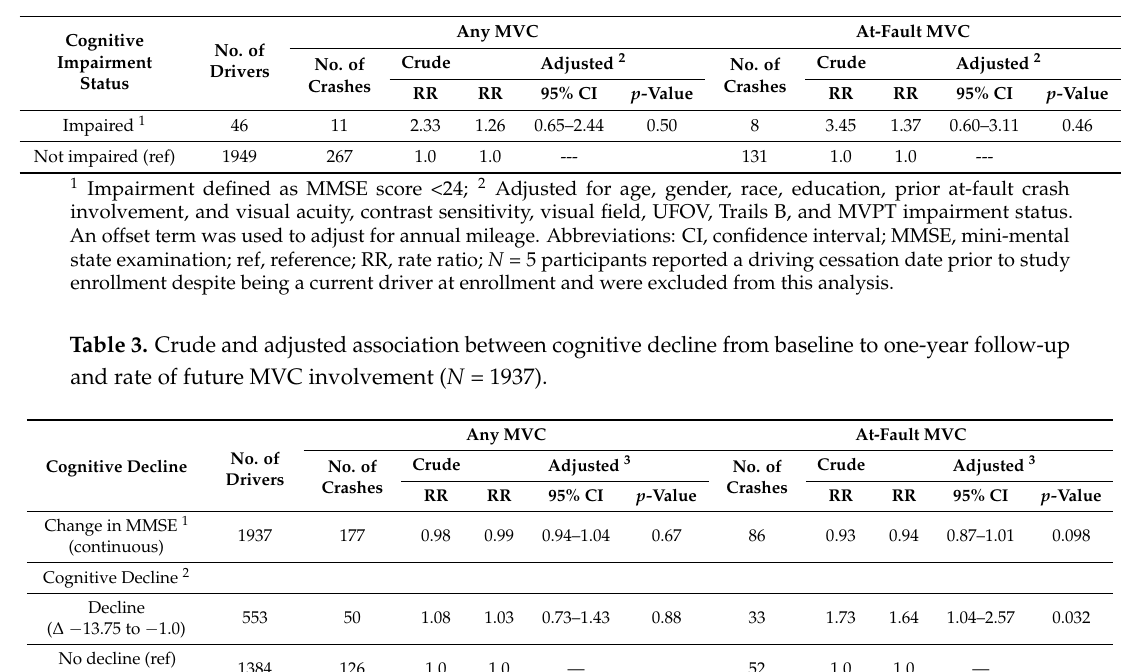
Table 2. Crude and adjusted association between cognitive impairment status at baseline and rate of future motor vehicle crash (MVC) involvement ( N = 1995).